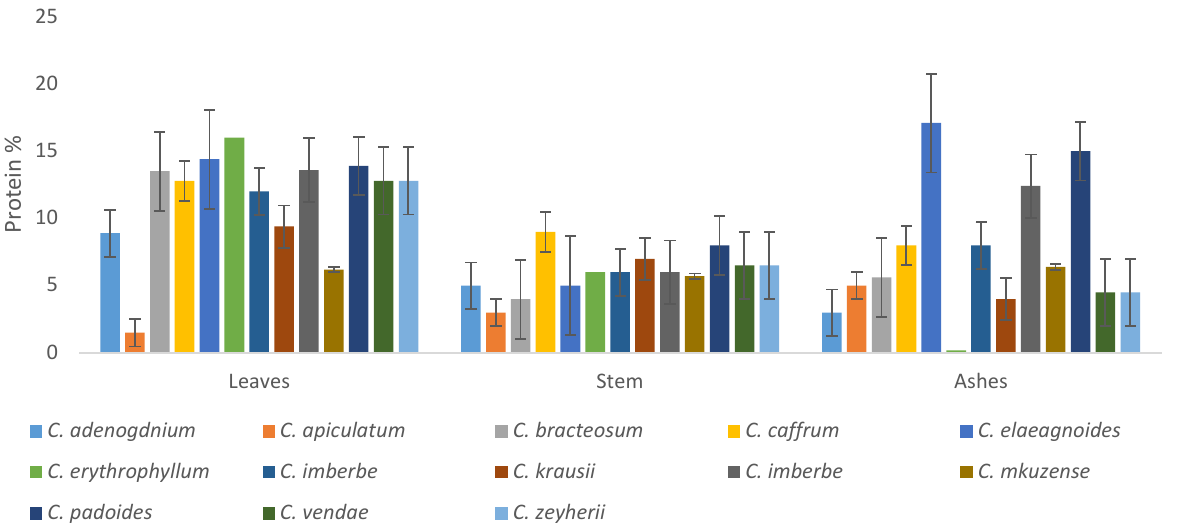
The protein content in the leaves ranged between, 2 and 14.4%, stems 4.04 and 7.66%, while the ashes contain protein in the range of 0.29–17.1%, as depicted in Figure 9. Gener- ally, the leaves had higher protein content compared to the stems and ashes of other species. However, the protein contents of the C. elaegnoides and C. padoides were interestingly high.